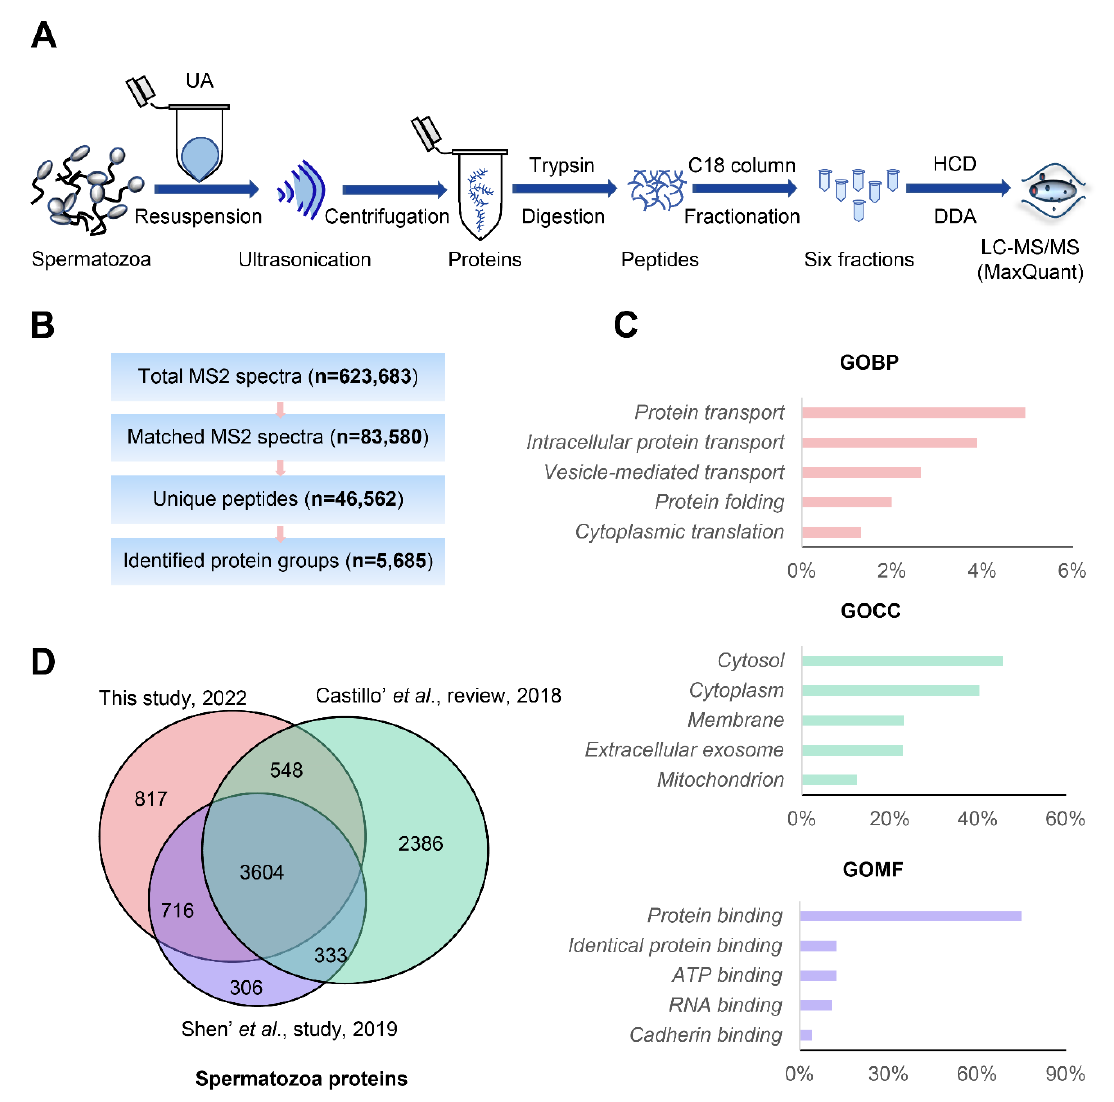
Figure 2. In-depth proteomics analysis of human sperm. ( A ), in-depth proteomic workflow of human sperm based on DDA; ( B ), analysis summary of LC-MS/MS spectral database search: total MS2 spectra, matched MS2 spectra, unique peptides and identified protein groups; ( C ), Gene Ontology analysis of identified proteins; ( D ), sperm protein groups identified currently compared with the previous study and review.